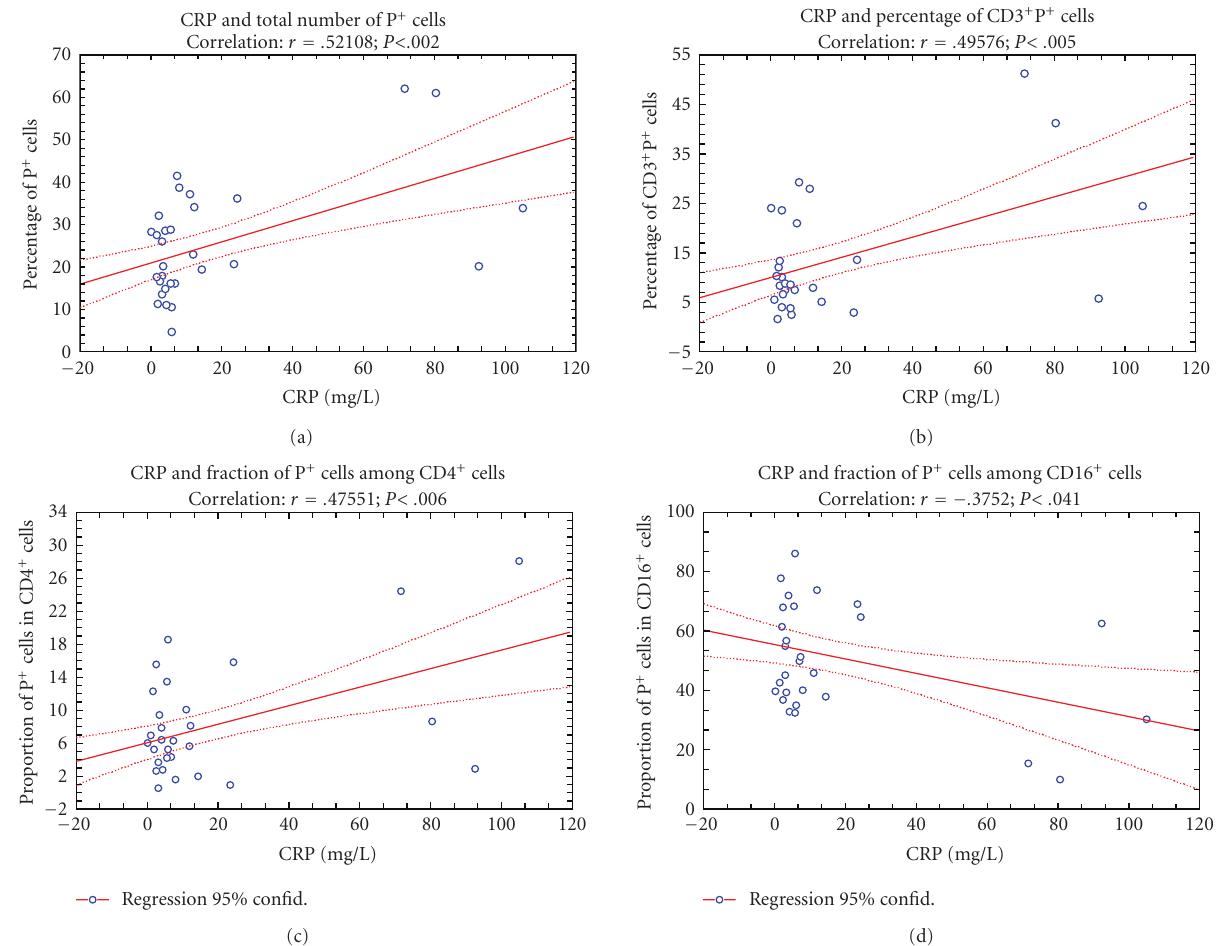
Figure 7: Correlation ( r ) between preoperative serum levels of C-reactive protein (CRP) and total number of perforin positive cells, CD3 + P + cells and fraction of perforin positive (P+) cells among CD4 + T cells, CD8 + T cells or CD16 + NK cells in preoperative samples of